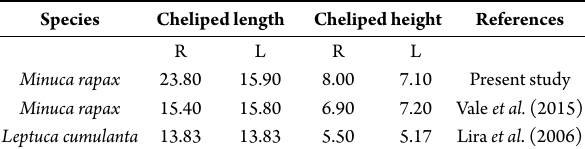
Table 2 . Hypertrophic chela dimensions (mm) in adult male fiddler crabs species according to current generic combinations. R, right cheliped; L, left cheliped